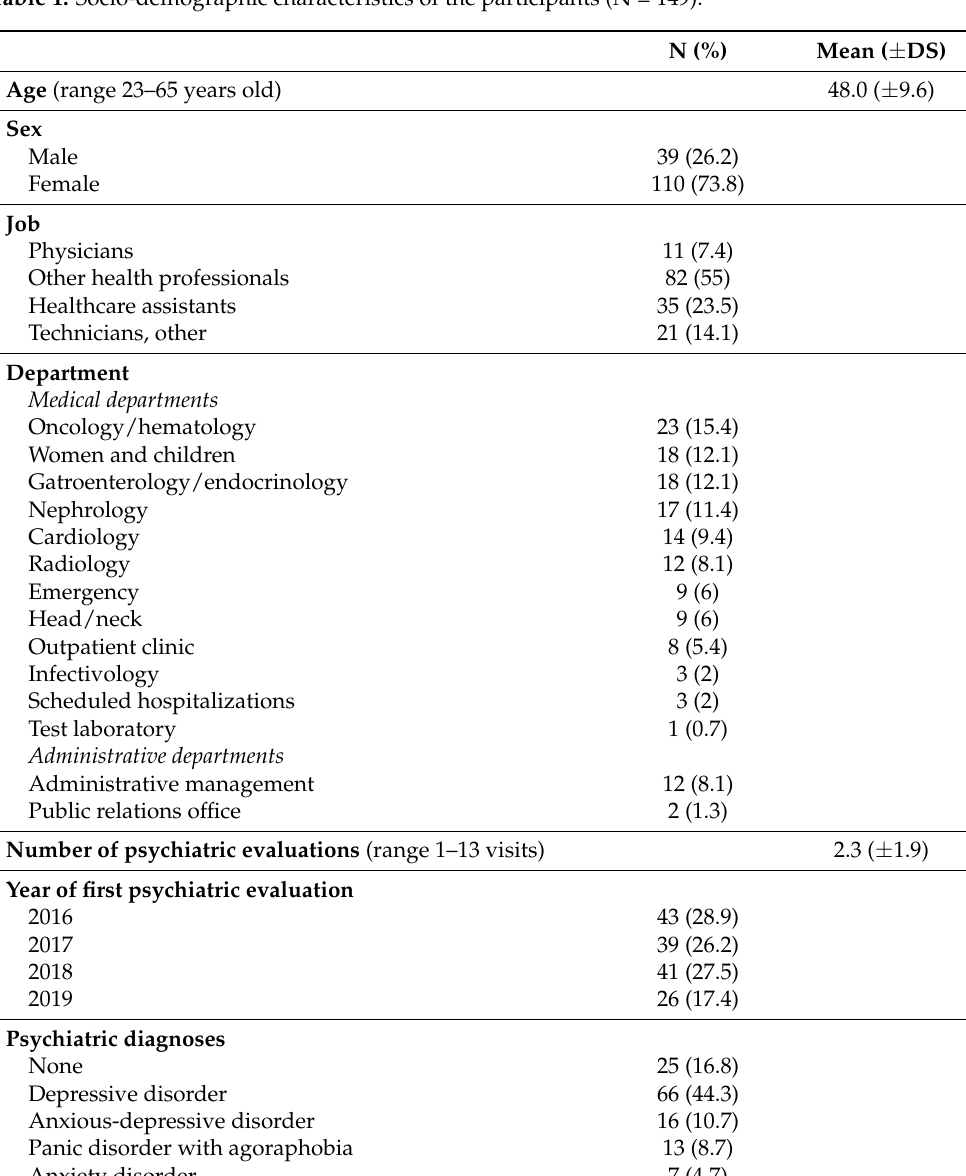
Table 1. Socio-demographic characteristics of the participants (N =